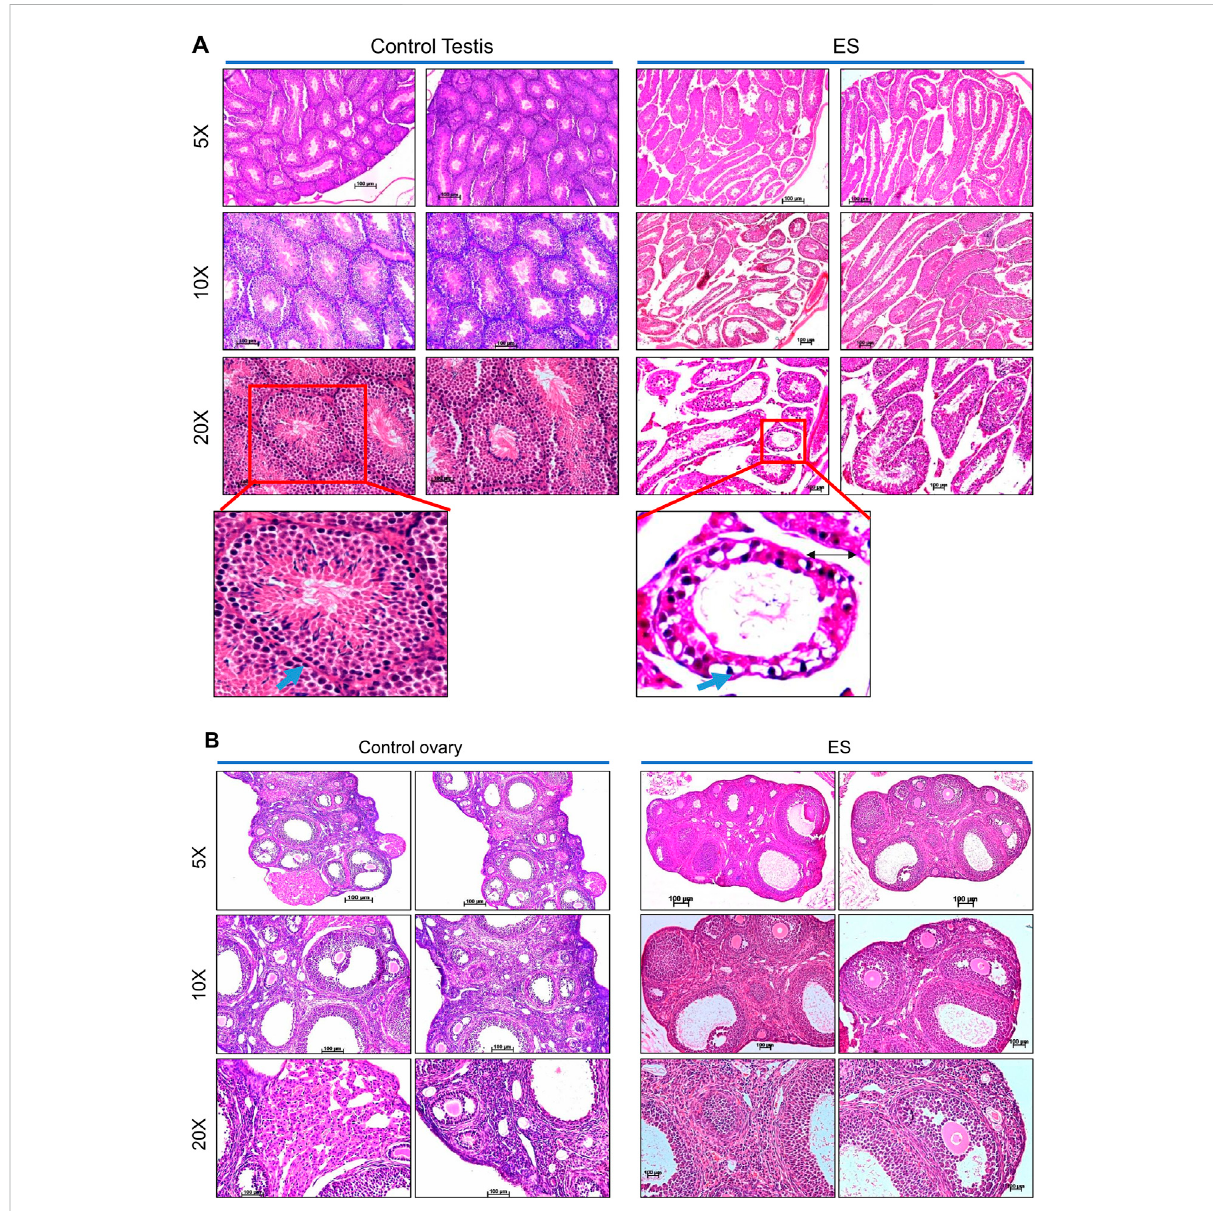
FIGURE 4 Histopathological examination of reproductive organs from ES-exposed mice. (A) Histopathology of testis of mice following ES administration. Control indicates testis tissue from mice with no treatment, and ES represents tissue from ES-treated mice (5 mg/kg, 10 doses; n = 2; Magni fi cation: ×5, ×10, and ×20). To evaluate long-lasting effects of exposure to ES, tissue samples were collected after 8 months following exposure. Nuclear components, including heterochromatin and nucleoli were stained by haematoxylin as deep blue or purple while eosin-stained cytoplasmic components like collagen, elastic fi bers, muscle fi bres and red blood cells. The blue arrows indicate the spermatogonia cells in basal epithelial layer, black arrow in ES indicates the interstitial space between the seminiferous tubules. (B) Histopathology of the ovary of mice following ES administration (5 mg/kg, 10 doses) after 8 months of exposure. The experiments were repeated two independent time for each tissue. Control indicates ovary tissue from mice with no ES treatment and ES represents tissue from ES exposed mice (Magni fi cation: ×5, ×10, and ×20; Scale bar: 100